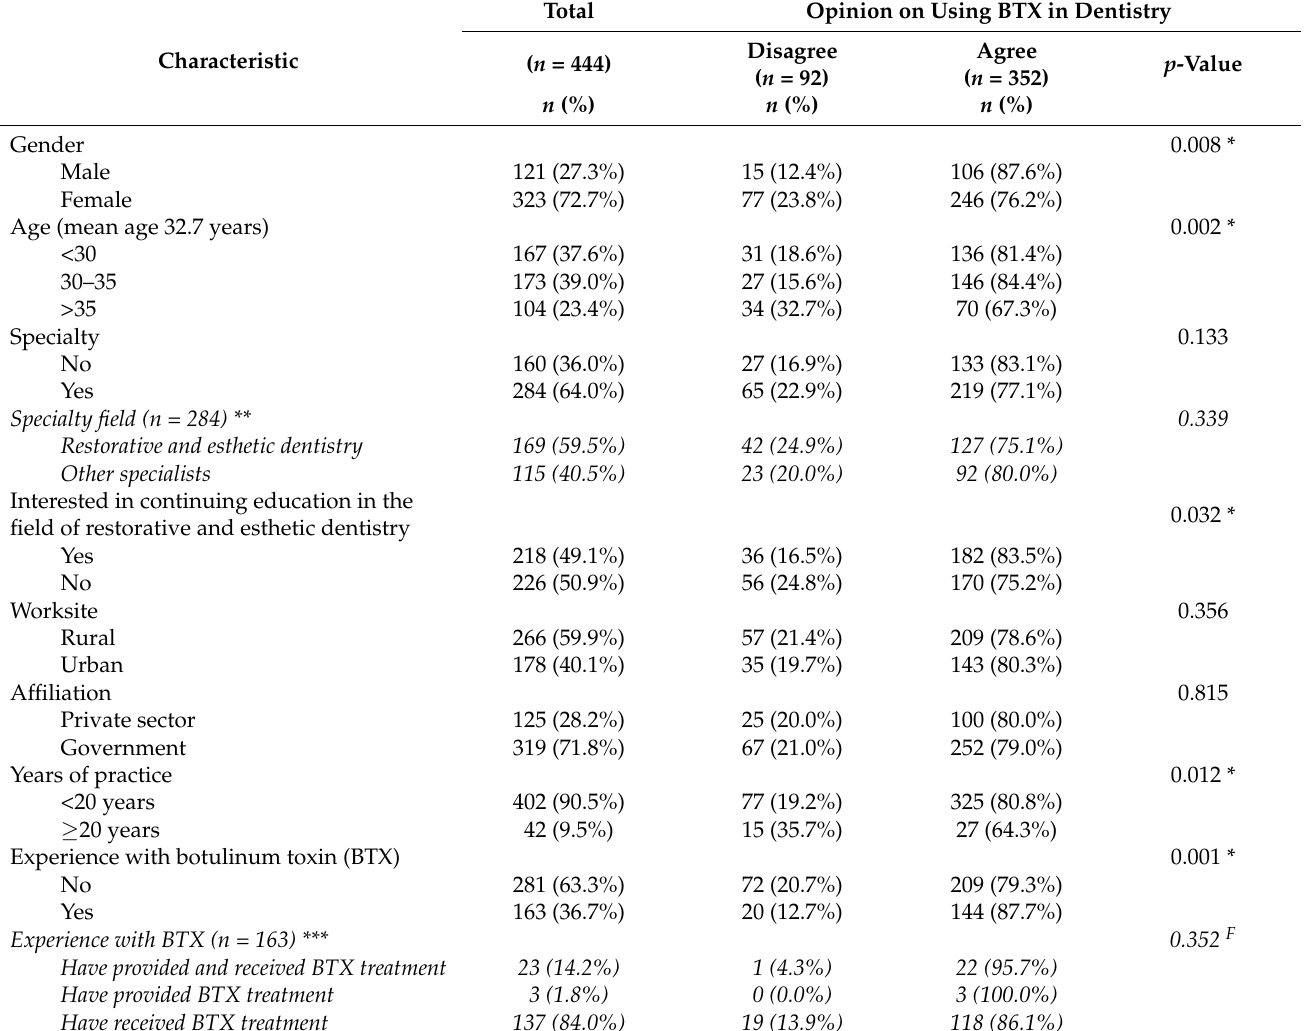
Table 1. Demographics data of